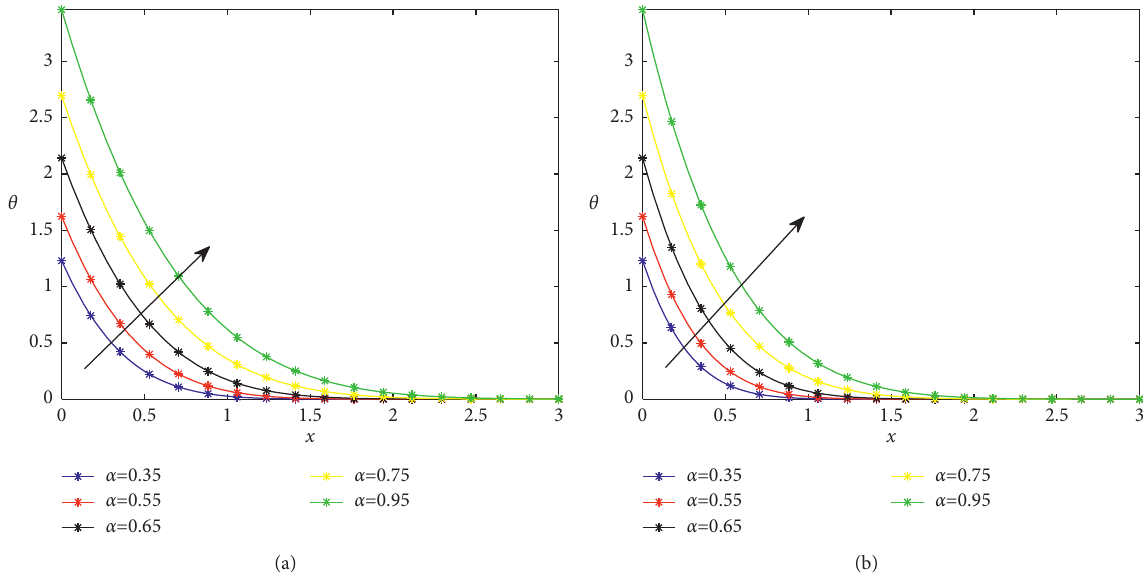
Figure 3: Concentration for different values of the order α for Sc � 10 (a) and Sc � 15 (b).